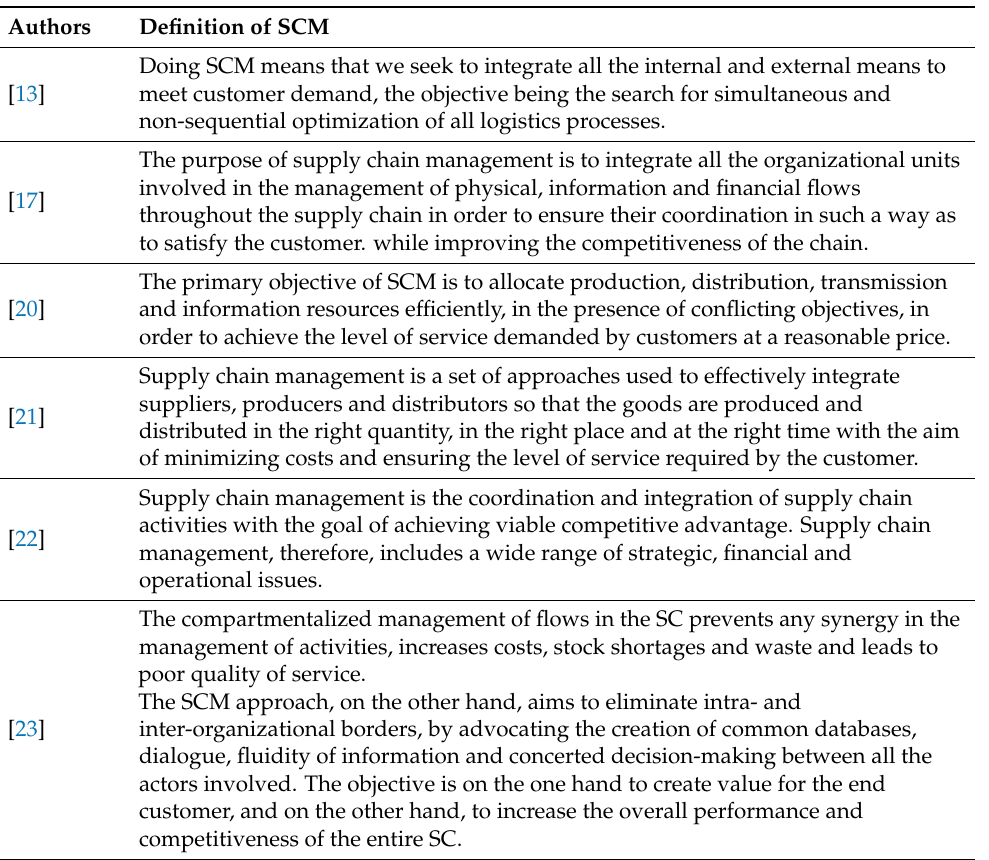
Table 2. Summary of some SCM